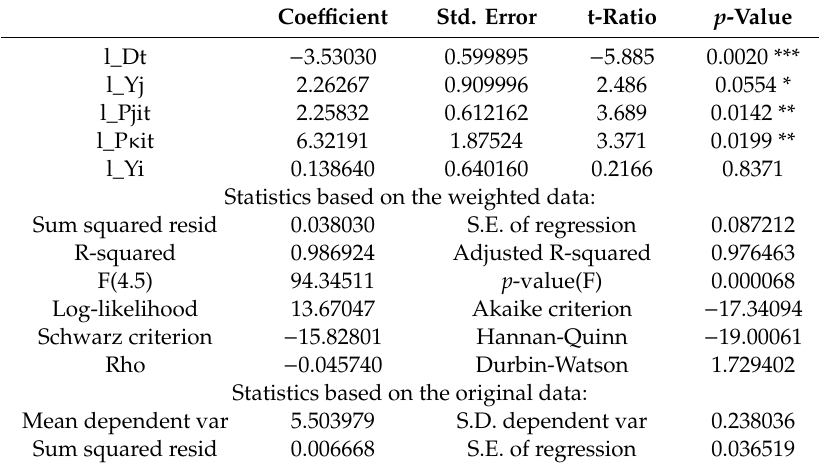
Table 12. FGLS estimation of Hungarian tourist consumption in Croatia – general model. Model 3: FGLS, using observations 2009–2018 (T = 10); dependent variable: l_TXji; variable used as weight: l_Dt.